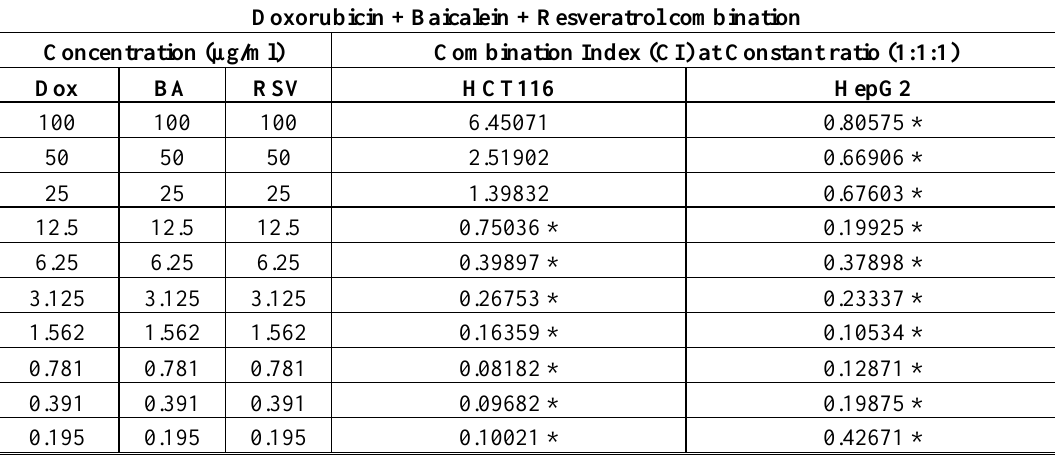
Table 2. Combination index (CI) for the combination of doxorubicin (Dox), baicalein (BA) and Resveratrol (RSV) using a constant ratio (1:1:1) against HCT116 and HepG2 cell lines.